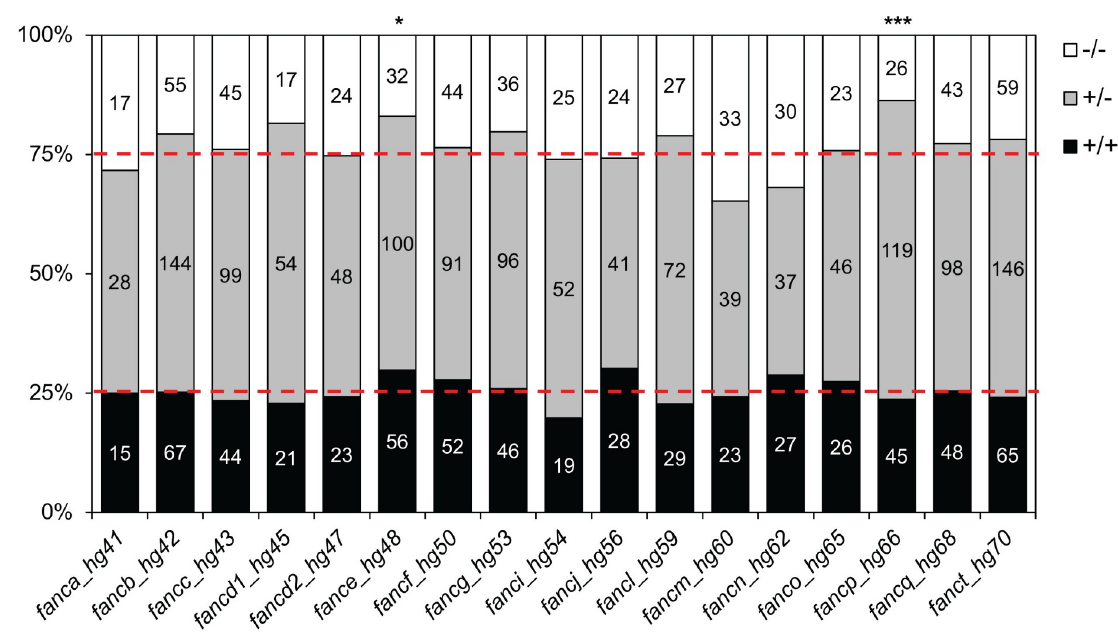
Fig 3. Homozygous knockout mutant fish for FA genes survive to adulthood. Progeny from inbred heterozygous fish for each allele were genotyped at 3–6 mpf. Data are shown as stacked bar chart, where each bar represents one mutant allele, as marked on the X-axis by the gene name and hg#. Segments on the bar show % of fish in each of the three expected genotypes: +/+, +/-, and -/- as marked on the Y- axis. Numbers in each segment depict the number of fish for each genotype. Data from one allele for each gene are shown here and the other allele is shown in S6 Fig. Reduced adult survival was observed in fance hg48/hg48 and fancp hg66/hg66 fish (Chi-square analysis, � p < 0.05, ��� p < 0.001, respectively).